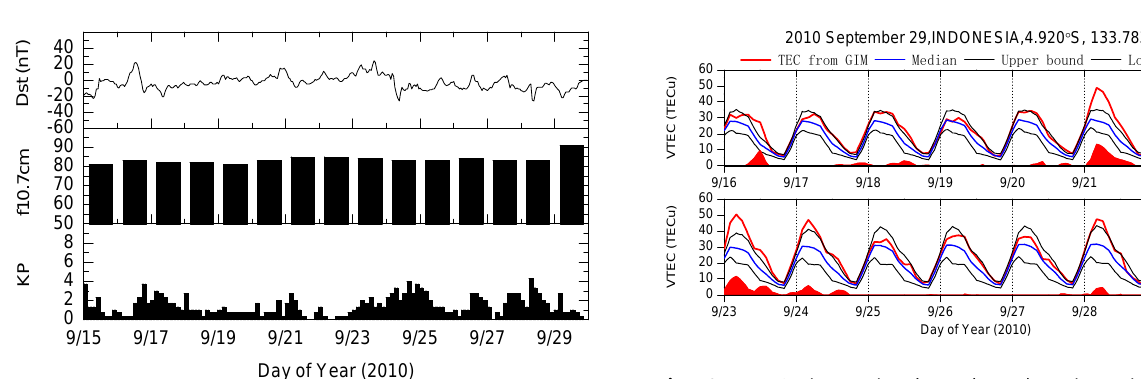
were more widely distributed, with the majority concentrated (over the) north of the equator in the Eastern Hemisphere. The grid points repeated 2 to 3 times were mainly concen- trated over eastern Asia, and those repeated several times were mainly concentrated in the vicinity of the epicenter. The grid points repeated 4 to 5 times were concentrated over the west side of the equator of the epicenter. The distribution of near the epicenter of abnormal grid points further confirm the correlation between the ionospheric anomalies and the earth- quake that occurred two days